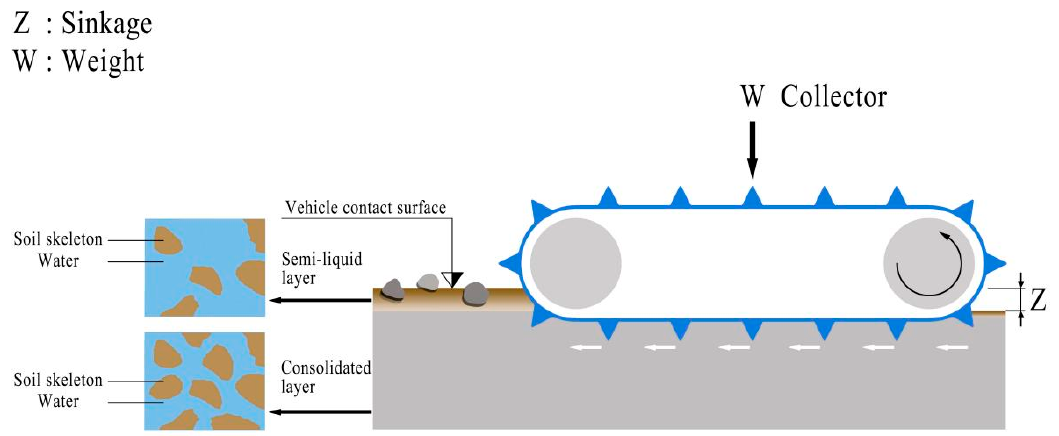
Figure 9. The interaction mechanism between subsea mining vehicles and deep-sea sediment.